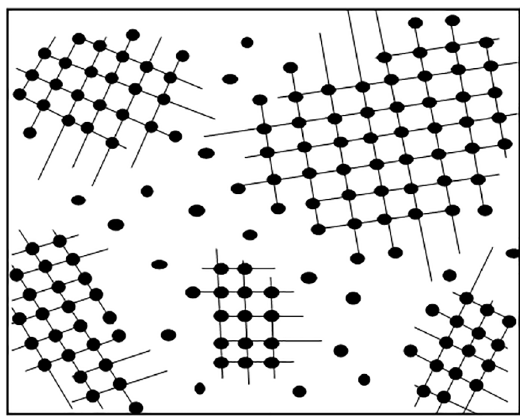
Figure 3. Micro-crystallite model.